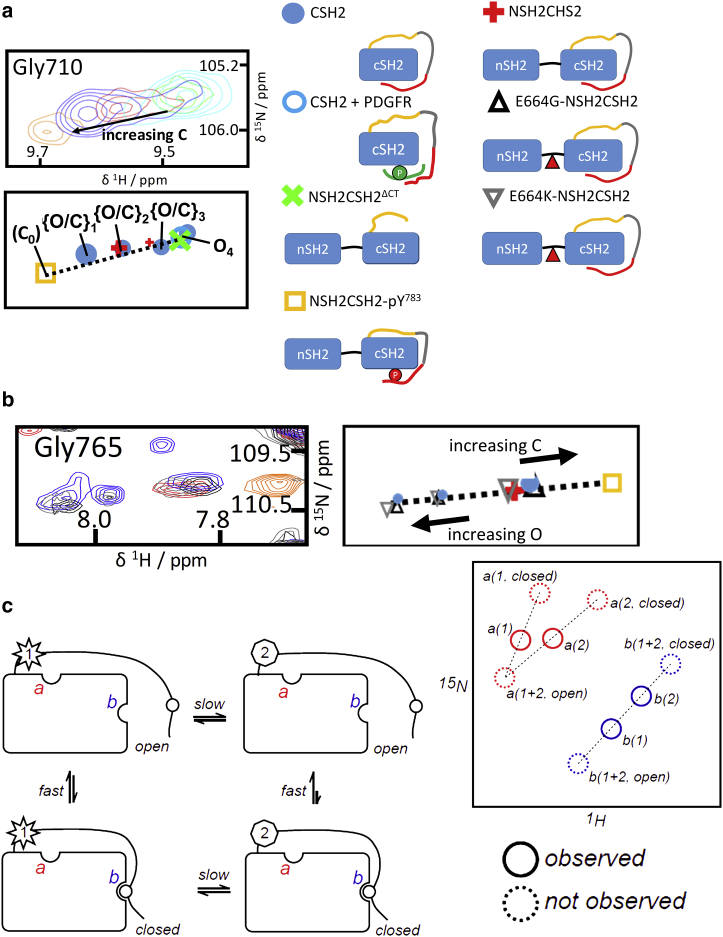
For a Figure360 author presentation of Fig. 7 c, see the figure legend at https://doi.org/10.1016/j.bpj.2018.05.031#mmc2.Evidence for multistate fast and slow exchange in CSH2 and NSH2CSH2 constructs. (a) CSH2 crosspeaks observed for residue Gly710 coincide with the peak positions of some other constructs (the color scheme is similar to that employed in Fig. 3, extended to include the complex of CSH2 with the platelet-derived growth factor receptor (PDGFR) phosphopeptide). The crosspeak label C0 indicates the NSH2CSH2-pY783 bound reference state that is not observed in CSH2. Four CSH2 states in slow exchange are identified: {O/C}1, {O/C}2, {O/C}3, and O (see main text). These states can also be observed over the course of a titration of CSH2 with PDGFR phosphopeptide (titration and further examples are shown in Fig. S15). The titration endpoint (CSH2 fully bound to the PDGFR phosphopeptide) is shown here. (b) Superposition of 1H,15N-HSQC spectra (700 MHz) indicates slow exchange for CSH2 and junction mutant constructs, exemplified by residue Gly765; color scheme as in (a). (c) Consideration of the effects of fast exchange in combination with “local” versus “remote” slow exchange on crosspeak patterns; see Figure360 for an extended animated version of this scheme. Top: in the scheme, the origin of slow exchange between states “1” and “2” (left and right, respectively) is illustrated conceptually by star and heptagon symbols. Consider now additional fast exchange (between top and bottom structures), for example corresponding to the association of an otherwise flexible appendage with the protein core. The rate of fast exchange depends on whether the molecule is in state “1” or “2.” We can now probe two sites a and b at which the combined exchange phenomena might be observed; the corresponding schematic spectra for both sites are shown on the right of the bottom panel. For site a, the origin of the slow exchange is “local”; for site b, it is “remote.” Note that in this study, the position of the fully “closed” position is known from experiments with NSH2CSH2-pY783. In the “local” slow case a, we would not expect crosspeak(s) to sit on a single vector between “open” and “closed” state coordinates. The observations described in this article correspond to the scenario depicted for site b, i.e., the crosspeak patterns that we have analyzed arise from residues apparently “remote” from the source of slow exchange.Figure360: An Author Presentation of Fig. 7